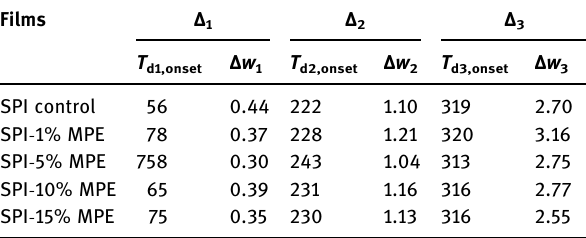
Table 7: Thermal degradation temperature ( T d , °C ) and weight loss ( Δ w , % ) of fi lms incorporated without and with MPE